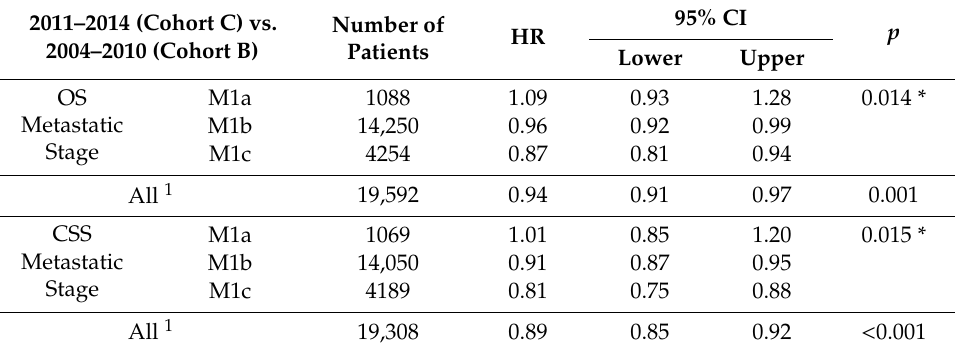
Table 4. Subgroup analysis of OS and CSS between Cohorts C and